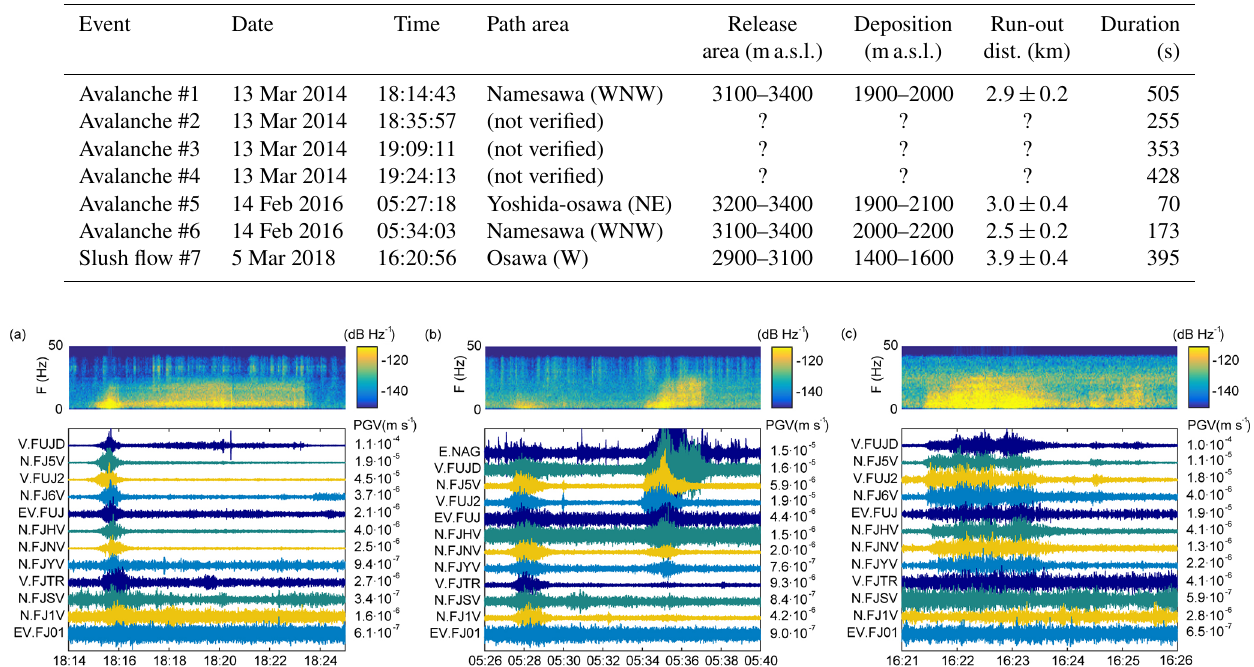
Table 1. Information on the three avalanche episodes in 2014, 2016, and 2018: type (avalanche or slush flow) and number of the event, date, time of seismic detection, path, elevation of the release area, elevation of the deposition area, run-out distance, and flow duration recorded at V.FUJD. There is no visual data to verify the paths, release, or deposition areas of avalanches #2–#4 (not verified events).